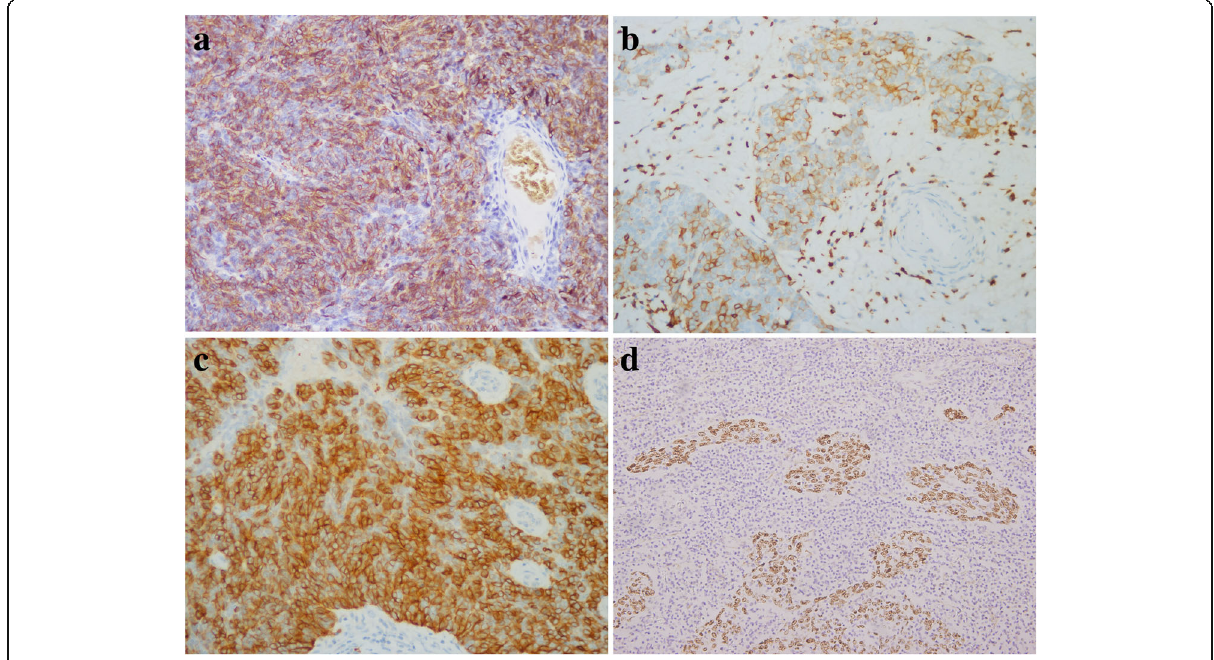
Fig. 5 a Immunohistochemistry showed diffuse staining for CD20 in atypical A thymoma. b and c Immunohistochemistry showed strong and diffuse staining for CD5 and CD117 in SCC. d Representative image of EBV signals determined by hybridization in situ in